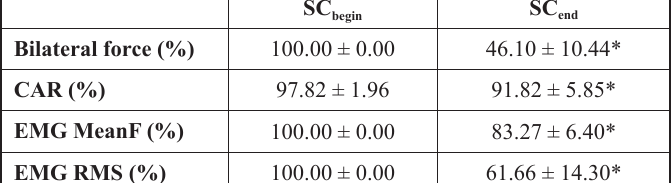
Figure 3. Correlations between changes in EMG-EMG alpha band (8-15 Hz) coherence of homologous vastus lateralis muscles and changes in bilateral